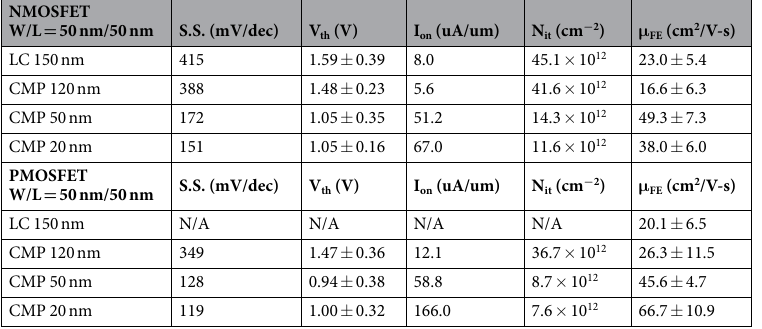
Table 2. Parameters of channel width/length (50 nm/50 nm) for NMOSFETs and PMOSFETs as the function of channel